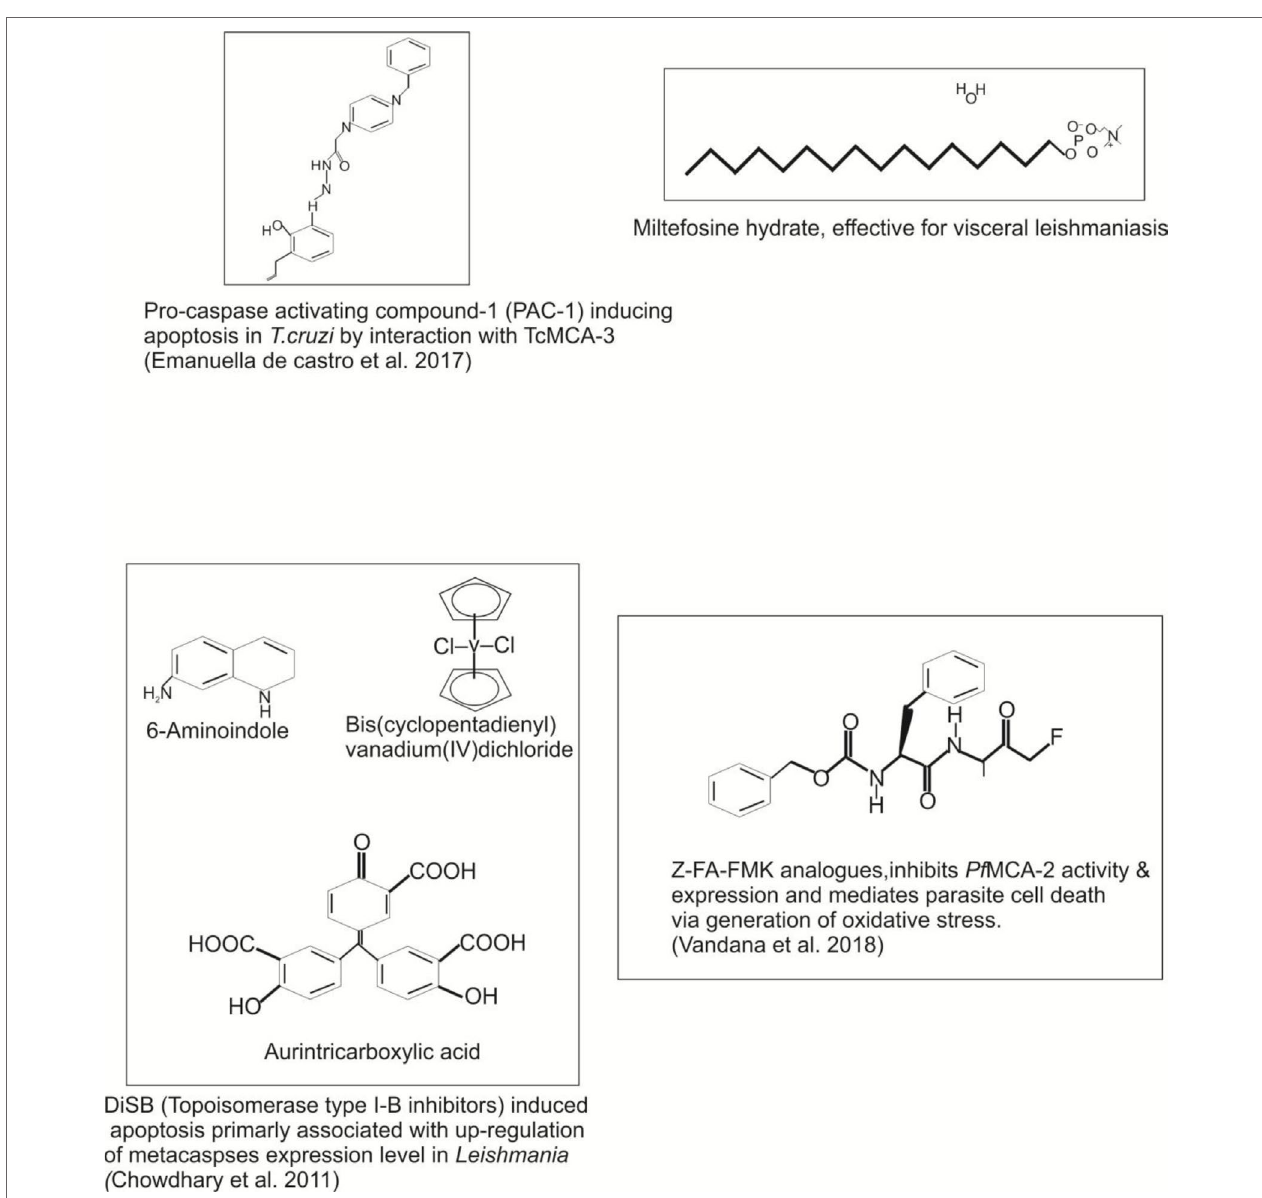
FIGURE 4 | Potential inhibitors/compounds used to target the different protozoan metacaspases, which could be further exploited as an effective drug target against infectious